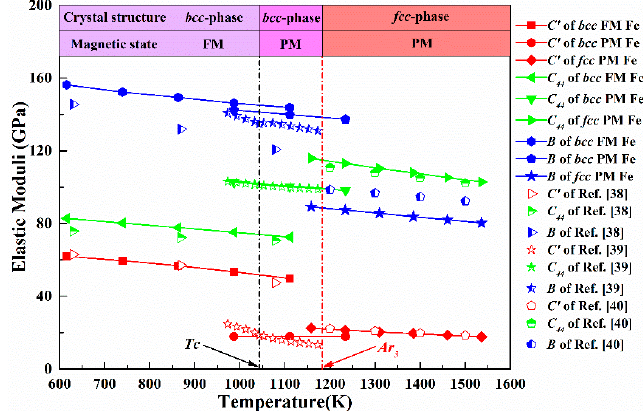
Figure 6. Calculated temperature dependence of elastic moduli of bcc-phase FM, bcc-phase PM, and fcc-phase PM in comparison with published data of References [38–40].